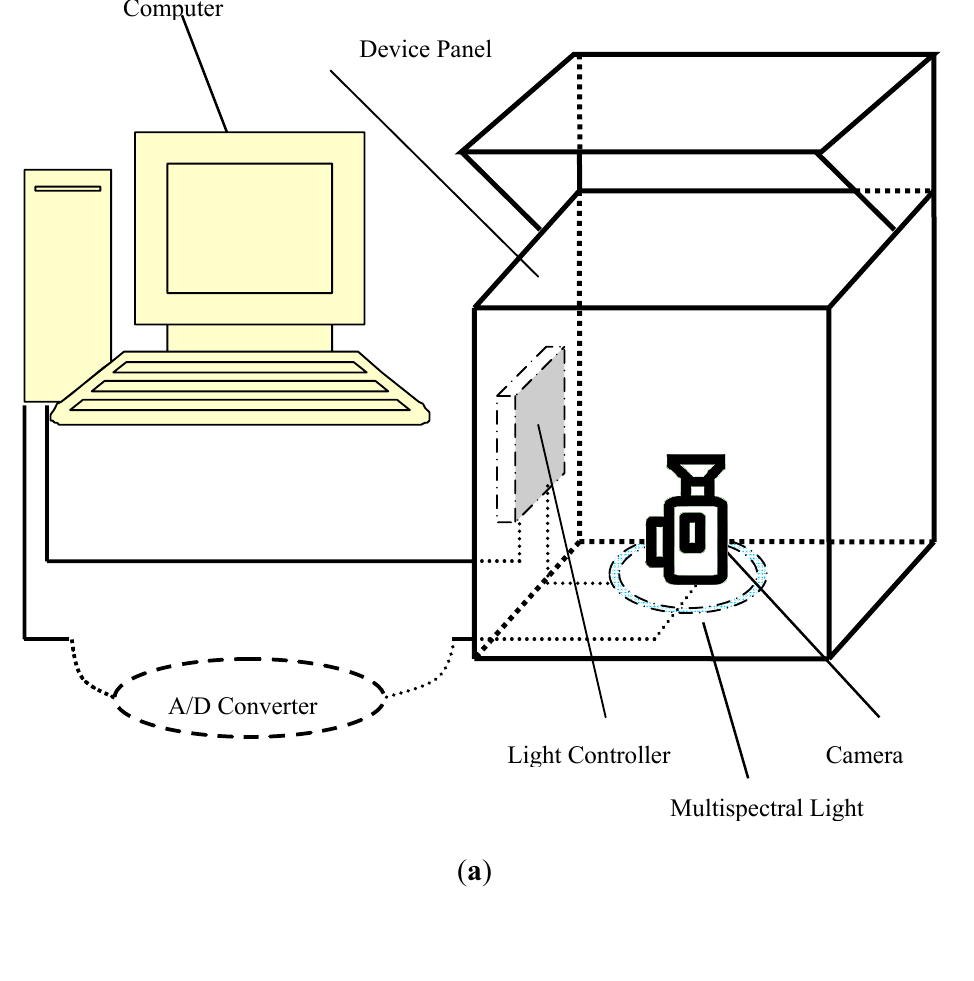
Figure 1. ( a ) The structure of the multispectral palmprint imaging sensor. ( b ) Device panel and how the palm of the hand is